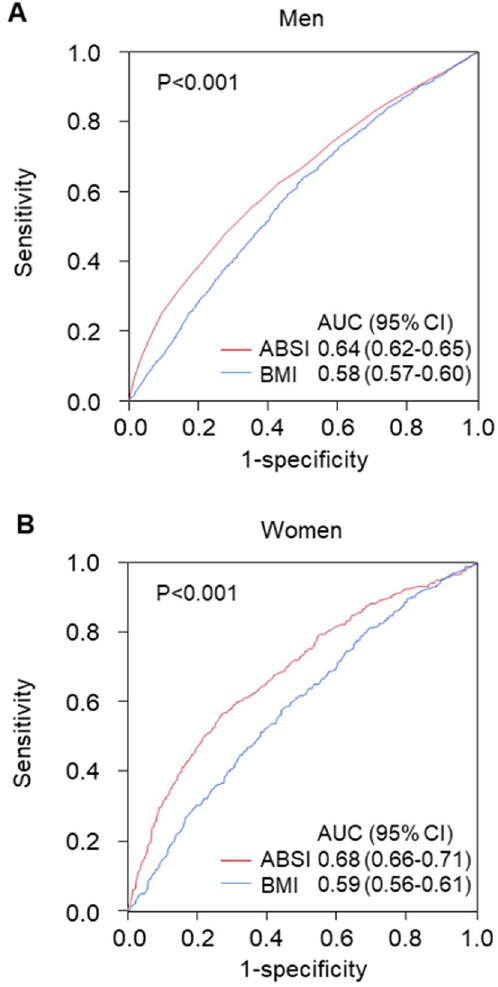
Figure 2. Receiver-operator characteristic curves of a body shape index (ABSI) and body mass index (BMI) for patients with a low quartile of flow-mediated vasodilation (FMD) in men ( A ) and in women ( B ). Low quartile of FMD indicates less than 3.6% in men and less than 3.1% in women. P values indicate the differences in areas under the curves between ABSI and BMI to predict a low quartile of FMD. ABSI a body shape index, BMI body mass index, AUC area under the curve, CI confidence